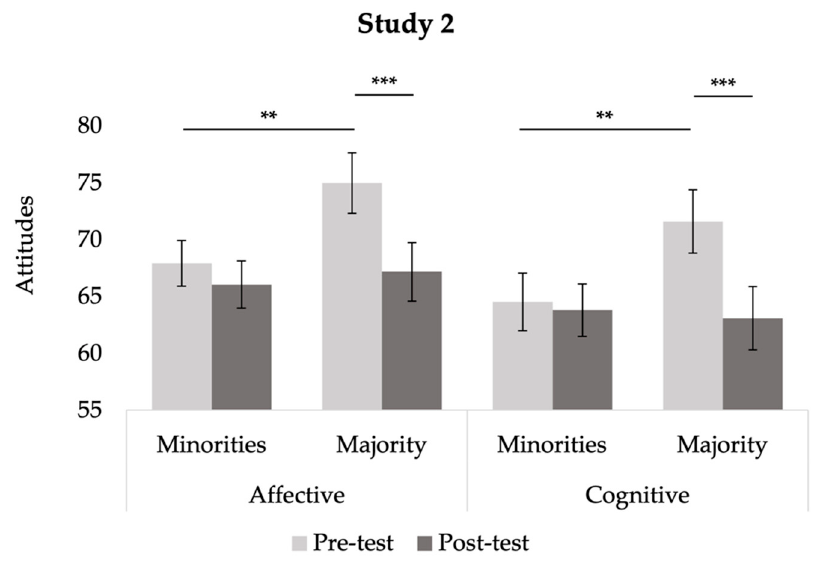
Figure 5. Plot depicting participants’ attitudes towards minorities and majorities at pre-test and post-test within each condition in Study 2. * p < 0.05, ** p < 0.01, *** p < 0.001. Self-Other Overlap